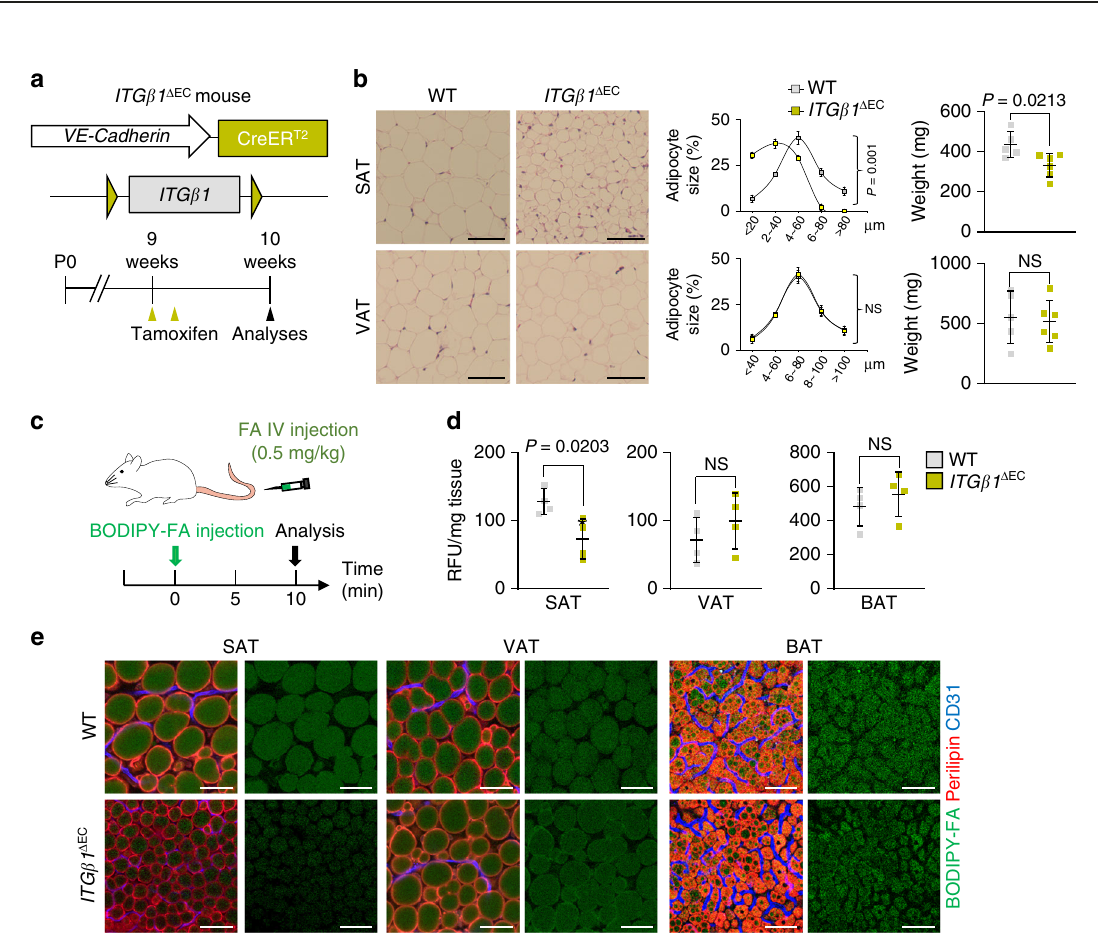
Fig. 6 Endothelial ITG β 1 drives subcutaneous fat distribution. a Generation of ITG β 1 Δ EC mouse, inducible and speci fi c deletion of ITG β 1 in ECs in 9-week- old mice, and their analyses 1 week later. Yellow arrowheads indicate daily injections of tamoxifen. b Representative H&E-stained images and comparisons in adipocyte size (diameter; μ m) of SAT and VAT in ITG β 1 Δ EC mice. Four different mice of each genotype were randomly selected to determine the adipocyte size and data are presented as % of total cells. Horizontal bars indicate mean ± SD and P values versus WT by two-tailed Student ’ s t test. Scale bars, 30 μ m. c Diagram for intravenous FA supply in ITG β 1 Δ EC mice. FA (BODIPY C-16, 0.5 g/kg) conjugated to BSA were administered intravenously into WT and ITG β 1 Δ EC mice and analyzed 10 min after. d , e Comparisons and representative images of FA uptake into different adipose tissues between WT and ITG β 1 Δ EC mice. Each dot indicates a mean of quadruplicate values from three independent experiments. Horizontal bars indicate mean ± SD and P value versus vehicle by two-tailed Student ’ s t test. NS not signi fi cant. Scale bars, 30 μ